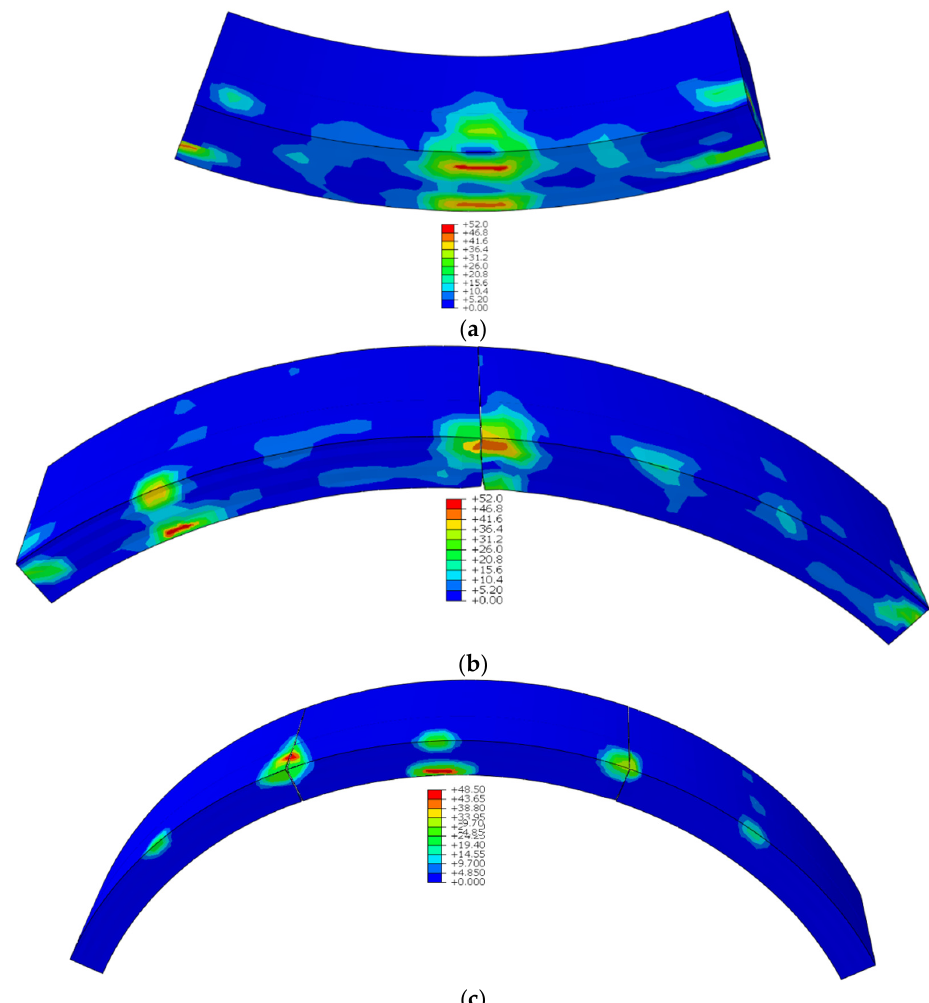
Figure 13. Damage to a segment in the presence of inward deflection when the asymmetric error angle is 1 ◦ : ( a ) first segment assembly (%); ( b ) second segment assembly (%); ( c ) third segment assembly (%). (Take the segment at the top as an